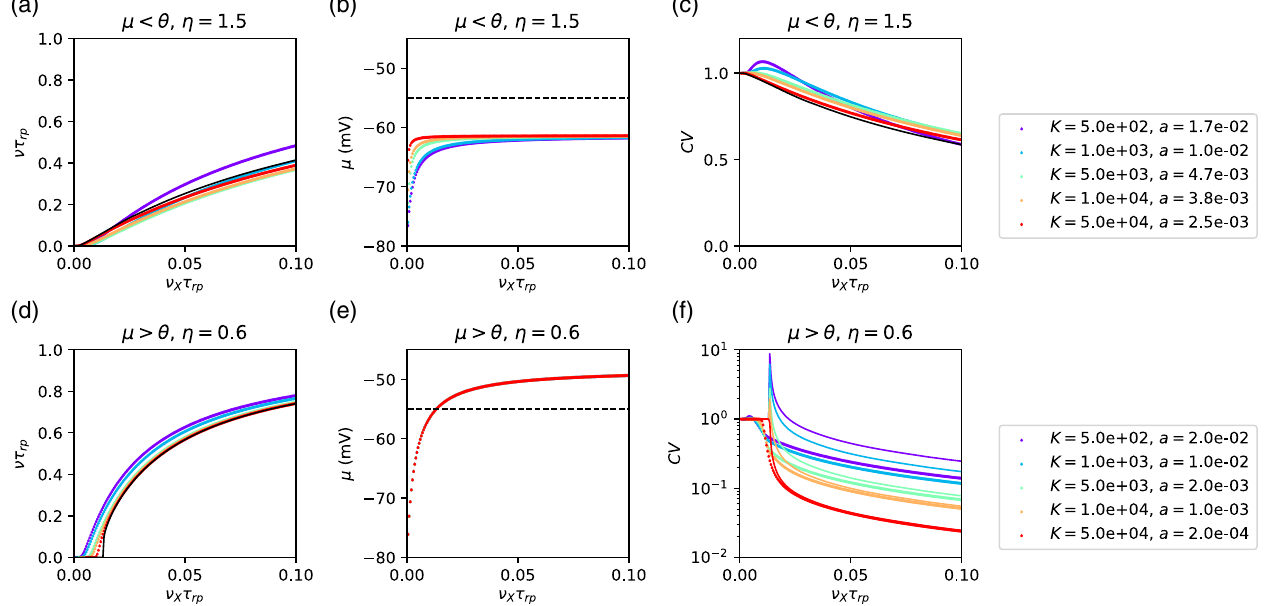
FIG. 11. Scaling relationships preserving firing in the large K limit. Colored dots represent mean field transfer function [(a),(b)], CV [(c),(d)], and membrane potential [(e),(f)] obtained from Eqs. (A13), (A14), and (A8), respectively. Different colors correspond to different values of a and K which are scaled according to Eqs. (B22) (first row) and (B21) (second row). Mean field predictions are well described by the relevant approximated expressions (continuous lines). For μ < θ , the transfer function and CV are described by Eqs. (B22) (a) and (B17) (c); both quantities are invariant as K increases. For μ > θ , the transfer function and CV are described by Eqs. (B21) (a) and (B9) (c); note that, as explained in the text, the firing is preserved while the CV becomes smaller as K increases (different line colors correspond to different values of K ). Parameters: g ¼ 12 and γ ¼ 1 = 4